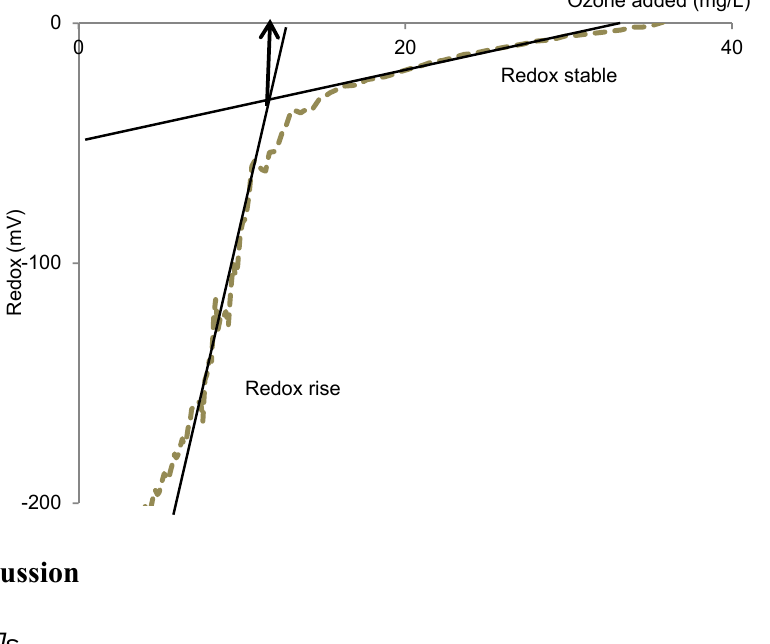
S emissions, i.e. , the 2